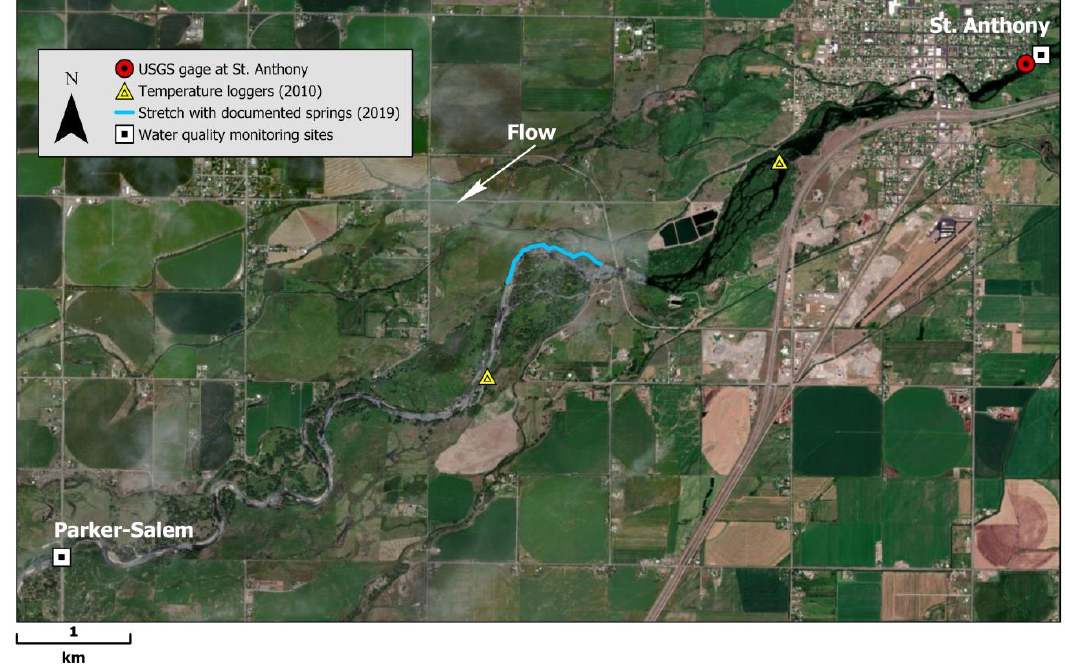
Figure 2. Map of field study reach, showing locations of U.S. Geological Survey (USGS) streamflow gage at St. Anthony, temperature loggers deployed in 2010, water-quality monitoring locations, and stretch where springs were documented in 2019. Data credit: ESRI.